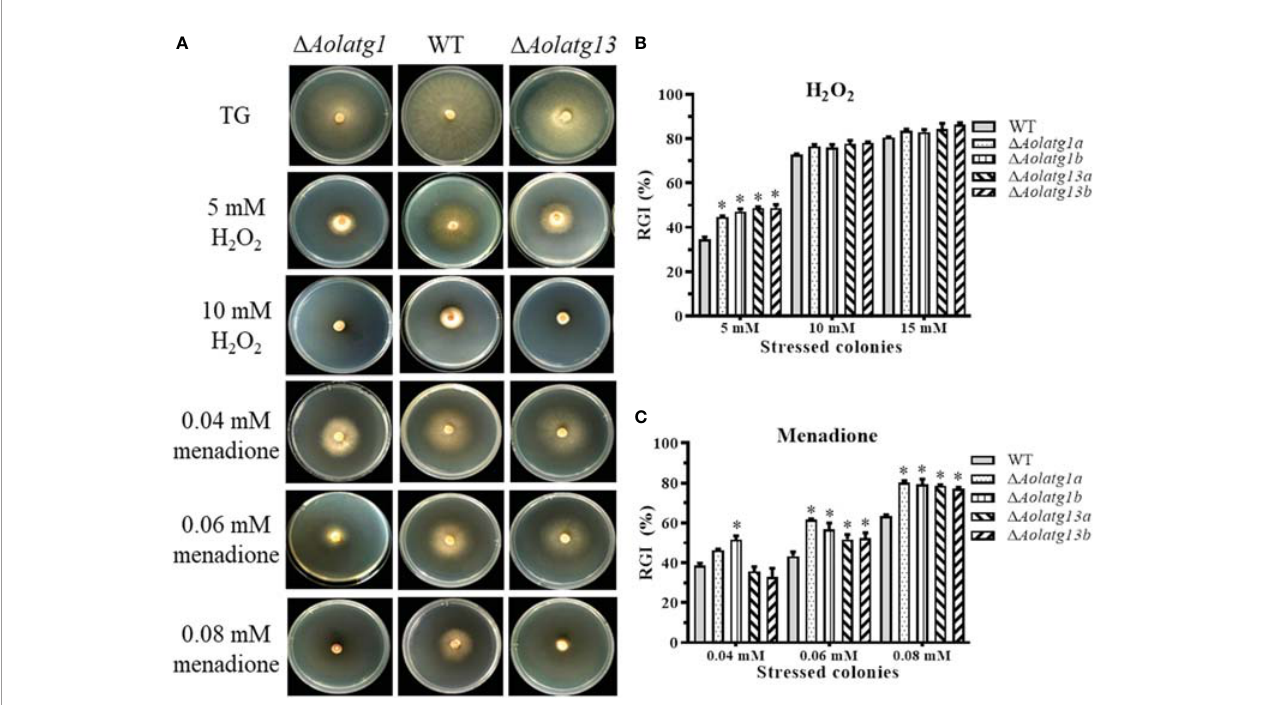
FIGURE 3 | Comparison of tolerance to oxidative stress in the WT and mutant strains of A. oligospora . (A) Colonial morphology of the WT and mutant strains on TG plates or plates containing H 2 O 2 and menadione at 28°C for 7 days. (B) Relative growth inhibition (RGI) of WT and mutant strains grown on the TG medium containing 5 – 15 mM H 2 O 2 for 6 days. (C) RGI of WT and mutant strains grown on the TG medium containing 0.04 – 0.08 mM menadione for 6 days. Data are presented as the mean ± standard deviation. Statistical signi fi cance of differences between mutant strains and WT strain is indicated as follows: * P < 0.05 (Tukey ’ s